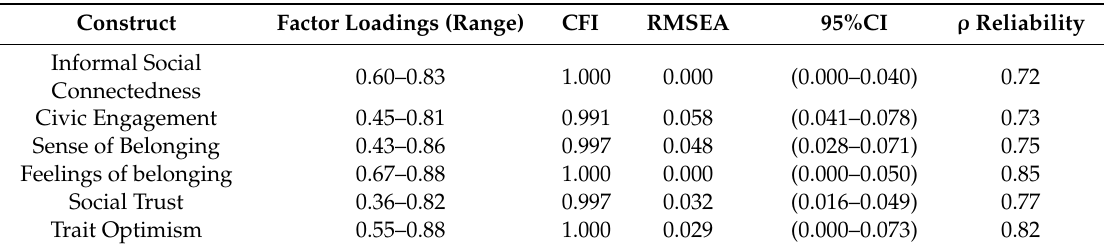
Table 2. Confirmatory Factor Analysis for composite social capital constructs using polychoric correlation matrices ( n =